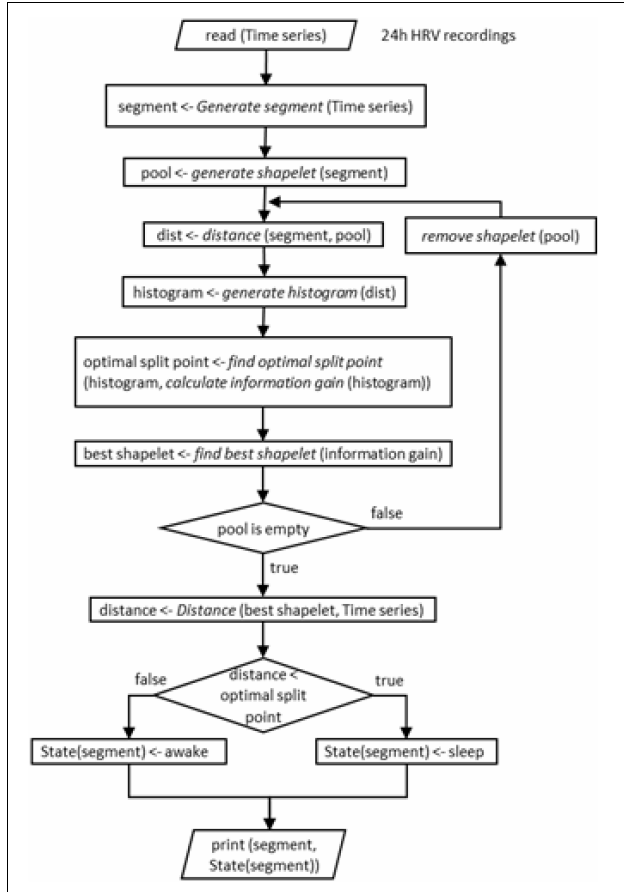
FIGURE 8 | Schematic representation (block diagram) of the entire procedure of our shapelet analysis and identification of best shapelet. It is shown here for easier orientation. Illustration is again done for a shapelet selected from